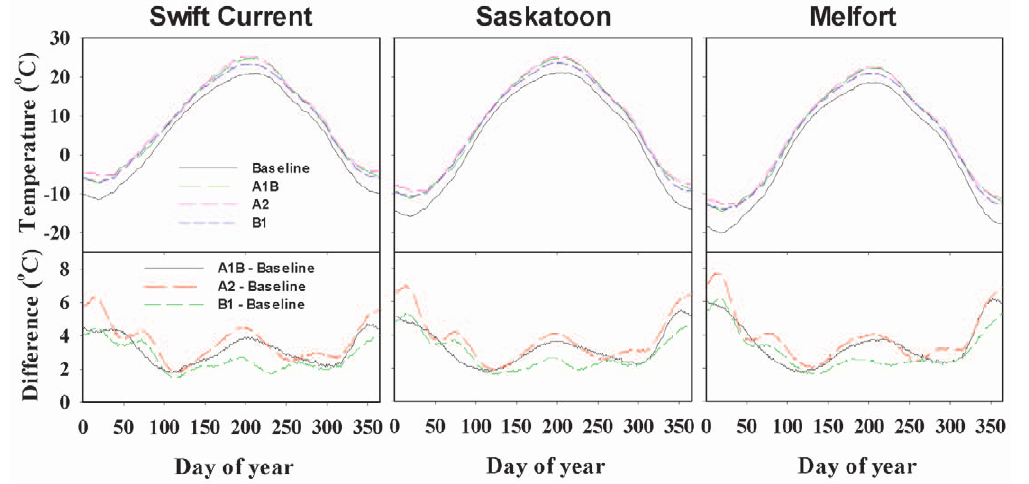
Figure 2. Daily mean temperature under baseline and three scenarios for 2050s, relative to the baseline period 1961–1990, and difference between the baseline and scenarios.